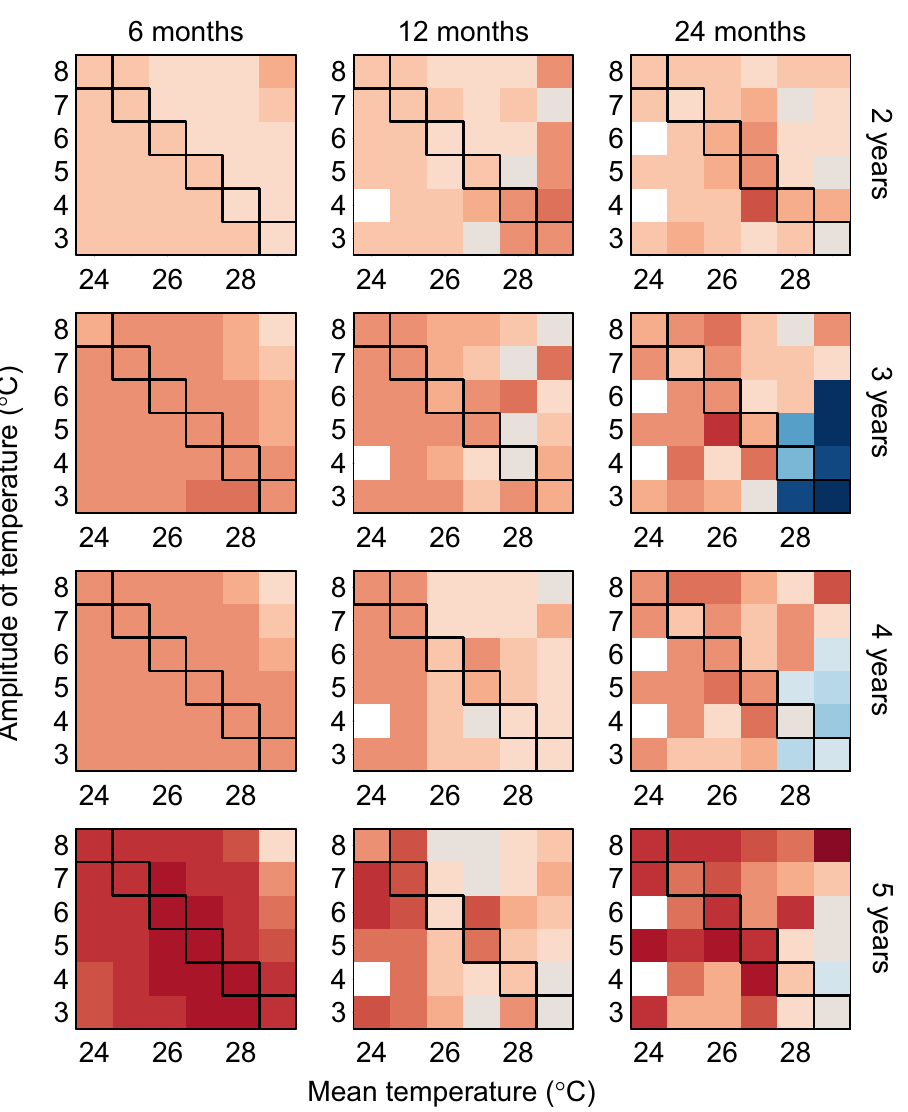
Fig 5. Comparing multiannual timescales in dengue caused by cross-protection and by multiannual fluctuations in the environment. We compare the mean wavelet power of dengue at the timescale of the single environmental multiannual fluctuation and at the timescale at which wavelet power is maximised without a multiannual fluctuation in temperature (the multiannual timescale attributable to cross-protection alone) by taking their difference. Columns and rows of panels are for the different assumptions on cross-protection and the different timescales of the multiannual fluctuation in temperature, respectively. Positive values (reds) mean that the multiannual fluctuation in temperature plays a more important role driving dengue multiannual dynamics, and negative values (blues) mean that dengue dynamics are less sensitive to the multiannual fluctuation in temperature. For example, for a mean temperature of 29˚C, a seasonal amplitude of 3˚C, a 3-year fluctuation in temperature, and a mean cross-protection of 2 years, we compared the mean wavelet power at a timescale of 3 years (that of the temperature multiannual fluctuation), with the mean wavelet power at a timescale of 5.1 years (the multiannual timescale at which wavelet power was maximised with no multiannual fluctuation in temperature, i.e., the peak on the top row of Fig 4C). The mean wavelet power was distinctly greater at the 5.1 year timescale than at the 3-year timescale, meaning dengue dynamics were insensitive to the multiannual fluctuation in temperature. Overall, temperature appears to be more important, but longer cross- protections (the right column) and higher mean temperatures are more likely to lead to a system dominated by intrinsic dynamics and less sensitive to multiannual fluctuations in temperature. Mean wavelet power is estimated for the duration of the multiannual fluctuation only (so for a 3-year fluctuation in temperature, mean wavelet power is estimated during those 3 years only). Here, the multiannual fluctuation has an amplitude 0.2 times that of the seasonal cycle, but the patterns are qualitatively similar for the other amplitudes of the multiannual fluctuations. The